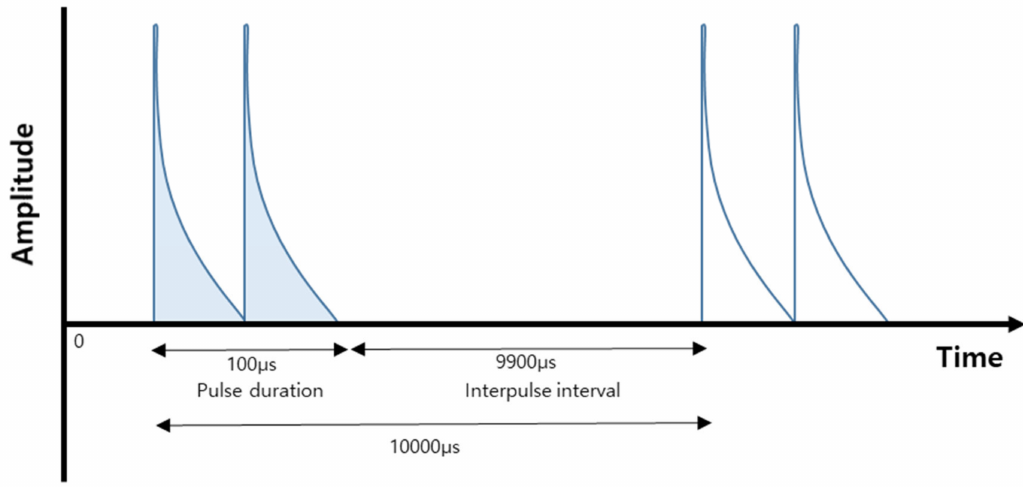
Figure 1. Illustration of the monophasic pulsed current with